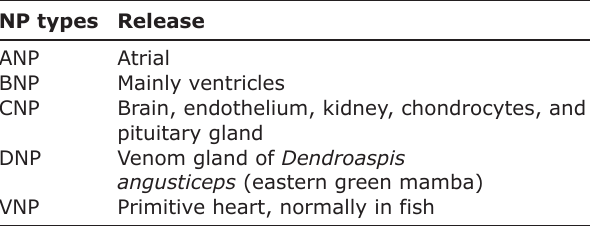
Table-1: Types of NP and release sites based on Baisan et al .